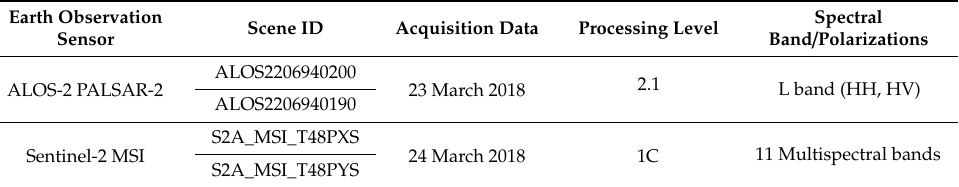
Table 2. Acquired earth observation data for this study.